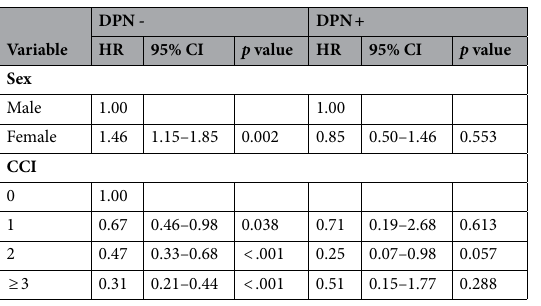
Table 5. Adjusted Hazard ratio for CTS release stratified by DPN presence according in participants with CTS and DM. Age and socioeconomic status were